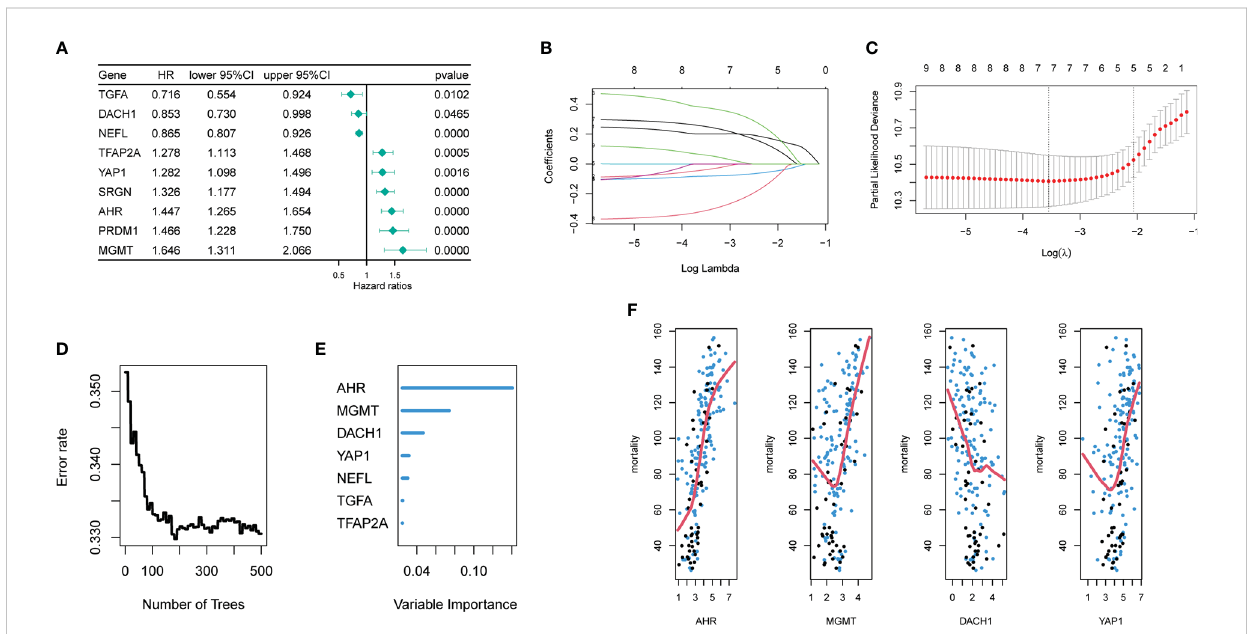
FIGURE 2 Acquisition of signature genes and construction of risk models. (A) Nine genes were signi fi cantly associated with the prognosis of temozolomide- treated patient, among which the HR values of TGFA, DACH1, and NEEL were less than 1, and they played a protective role, while the HR values of TFAP2A, YAP1, SRGN, AHR, PRDM1, and MGMT were more than 1, and they played a risky role. (B) The nine different colored lines represent nine different variables. As log( l ) increases, the regression coef fi cients of variables start to converge, eventually reaching 0. (C) As the variables